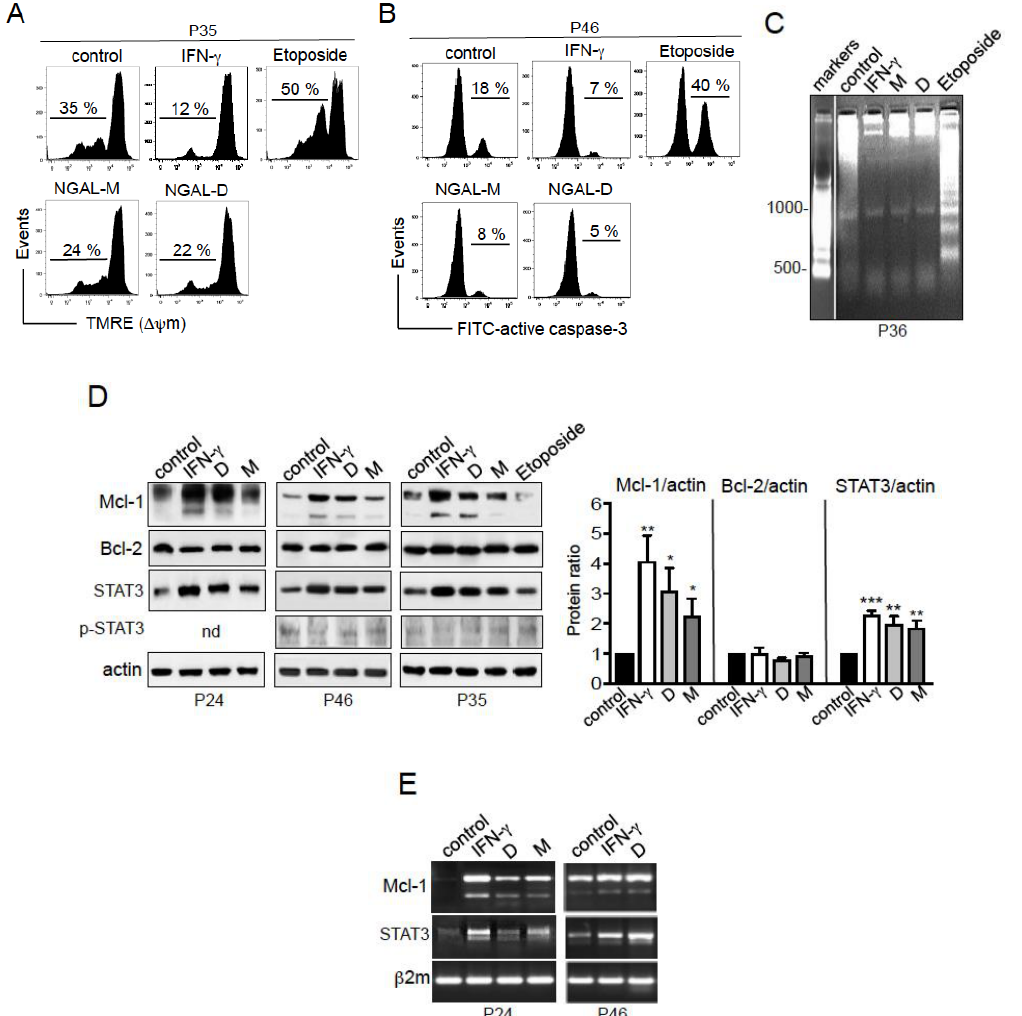
Figure 6. NGAL upregulates Mcl-1 and STAT3 in CLL cells. ( A ) Representative cytograms of CLL cells cultured for 24 h in the presence or absence of NGAL dimers or monomers (100 nM), IFN- γ (1000 U / mL) or etoposide (1 µ M); cells were labelled with the FL2 probe TMRE. The percentages refer to ∆Ψ m loss. ( B ) Representative cytograms of CLL cells cultured for 24 h in the presence or absence of NGAL dimers or monomers (100 nM), IFN- γ (1000 U / mL) or etoposide (1 µ M); cells were stained with rabbit IgG-FITC or anti-active caspase-3-FITC and then examined by flow cytometry. ( C ) CLL cells cultured for 30 h in the presence or absence of NGAL dimers or monomers (100 nM), IFN- γ (1000 U / mL) or etoposide (1 µ M); DNA fragmentation was evaluated by the detection of an oligonucleosome ladder by agarose gel electrophoresis. ( D ) CLL cells were cultured for 24 h in the presence or absence of NGAL dimers or monomers (100 nM), IFN- γ (1000 U / mL) or etoposide (1 µ M); after which lysates were Western blotted (reducing conditions) with antibodies against Bcl-2, Mcl-1 (Mcl-1 L and Mcl-1 S ), STAT3, p Y705 -STAT3 and actin. Three representative experiments (n = 6 in all) are shown. Data (n = 6) are expressed as the ratio between the analyte proteins and actin, and presented as mean ± SEM. Statistical relevance was assessed with the unpaired t -test; not done (nd); * p < 0.05; ** p < 0.01; *** p < 0.001. ( E ) CLL cells were cultured for 18 h in the presence or absence of NGAL dimers or monomers (100 nM) or IFN- γ (1000 U / mL). Then, the cDNAs were used as templates for PCR reactions using specific primers for Mcl-1 (Mcl-1 L and Mcl-1 S ), STAT3 and β2-microglobulin. 2.8. NGAL-Mediated CLL Cell Survival Involves the Src/STAT3/Mcl-1 Signaling Pathway